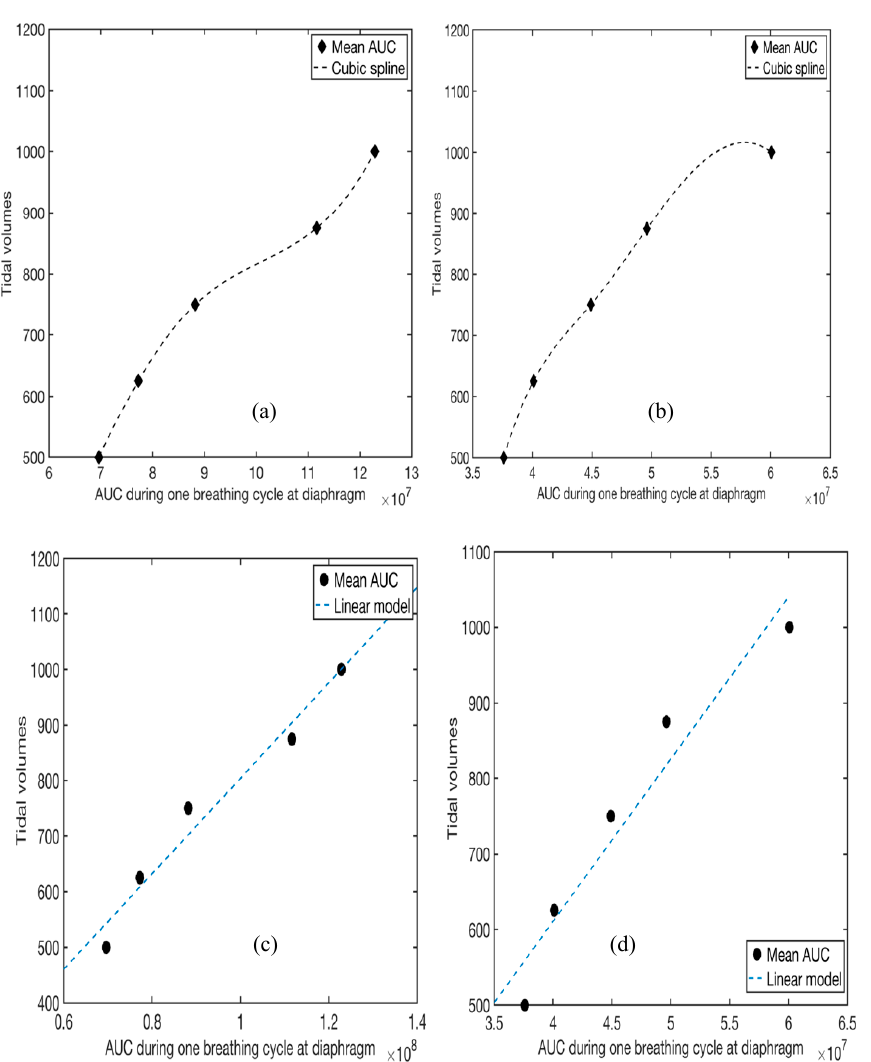
Figure 7. Curve fitting. The y-axis represents the tidal volume and the x-axis represents the mean